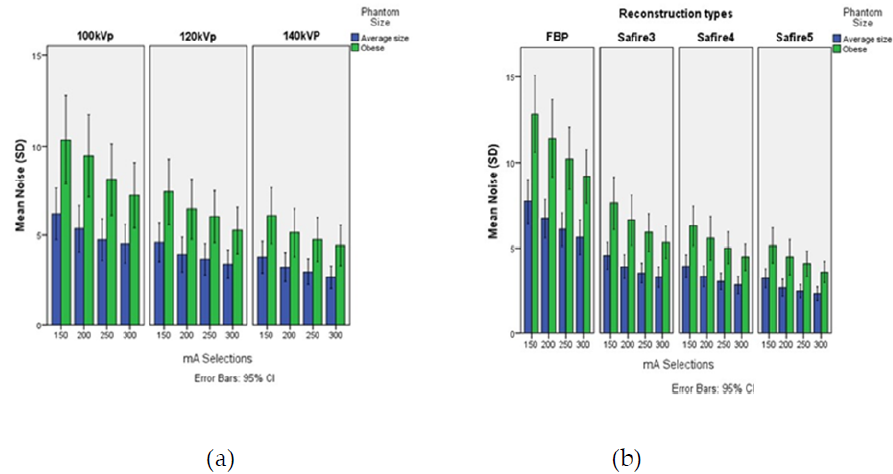
Figure 5. ( a ). Mean noise values ± SDs for both phantoms (normal-weighted and obese) across the kVp applied selections ( b ). Mean noise values ± SDs for both phantoms (normal-weighted and obese) across the applied reconstruction types.